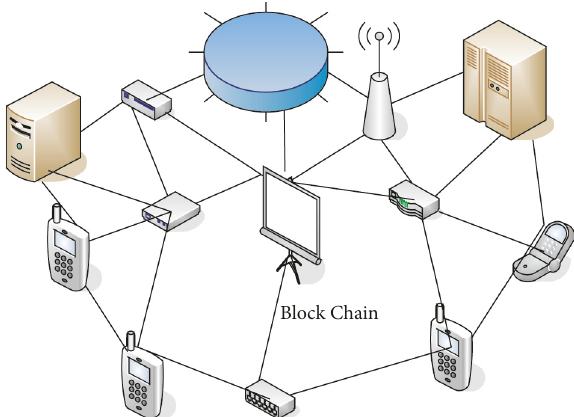
Figure 1: Blockchain